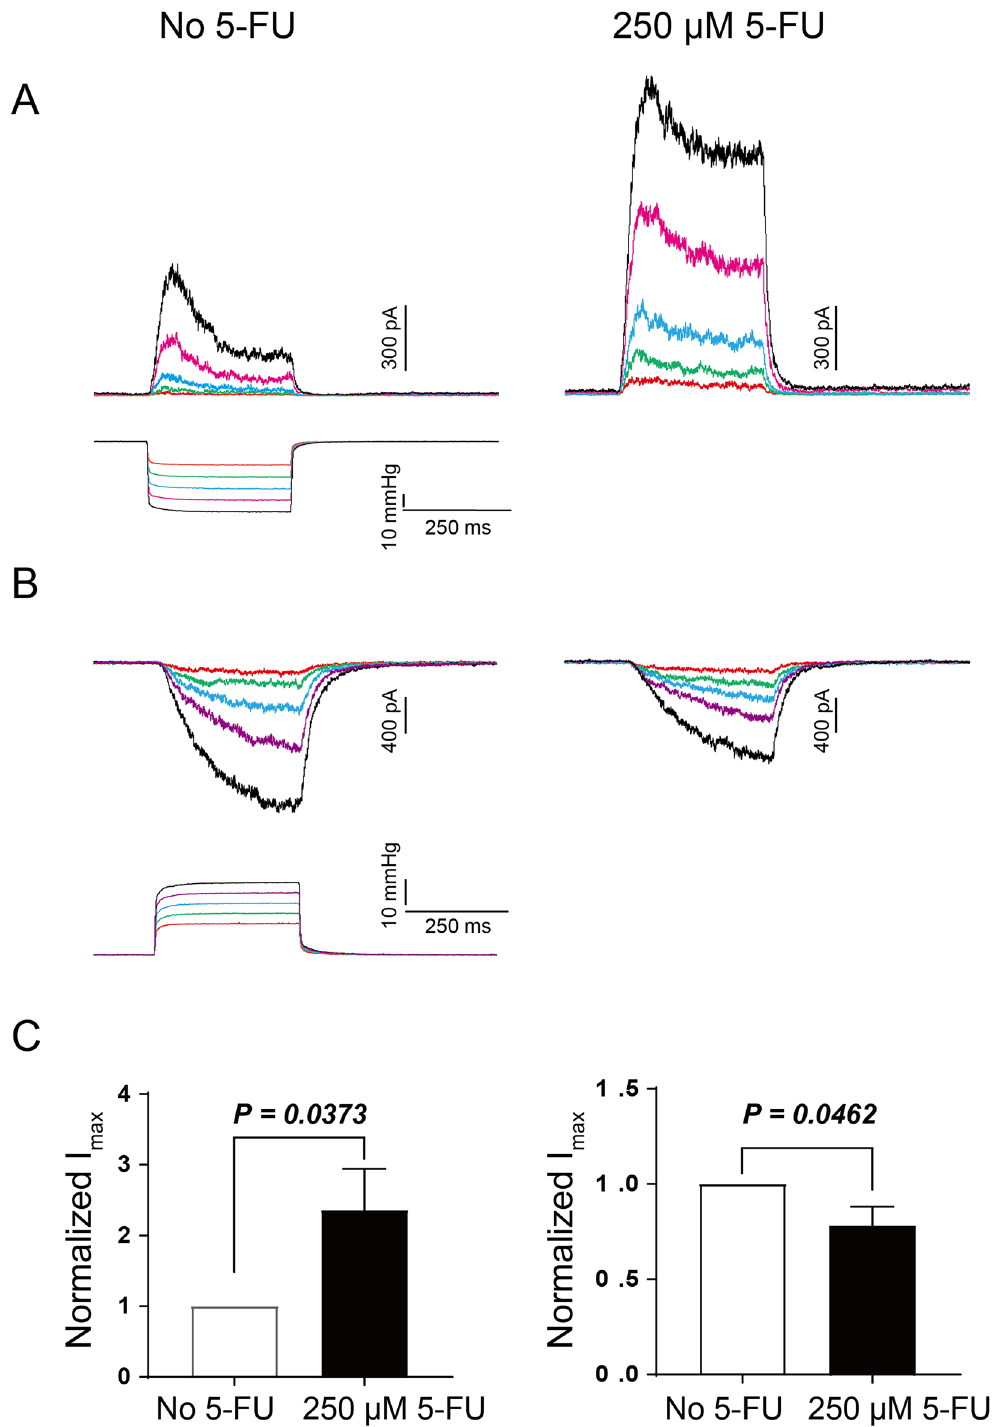
Figure 7. Effect of 5-FU on TREK-1 heterologously expressed in HEK293T cells. ( A , B ) 5-FU sensitizes TREK-1 from the cytoplasmic side (I/O), while it reduces the current from the opposite leaflet (O/O). ( C ) Normalized current before and after 5-FU, inside-out (left, n = 7, p = 0.0373) and outside-out (right, n = 8, p =